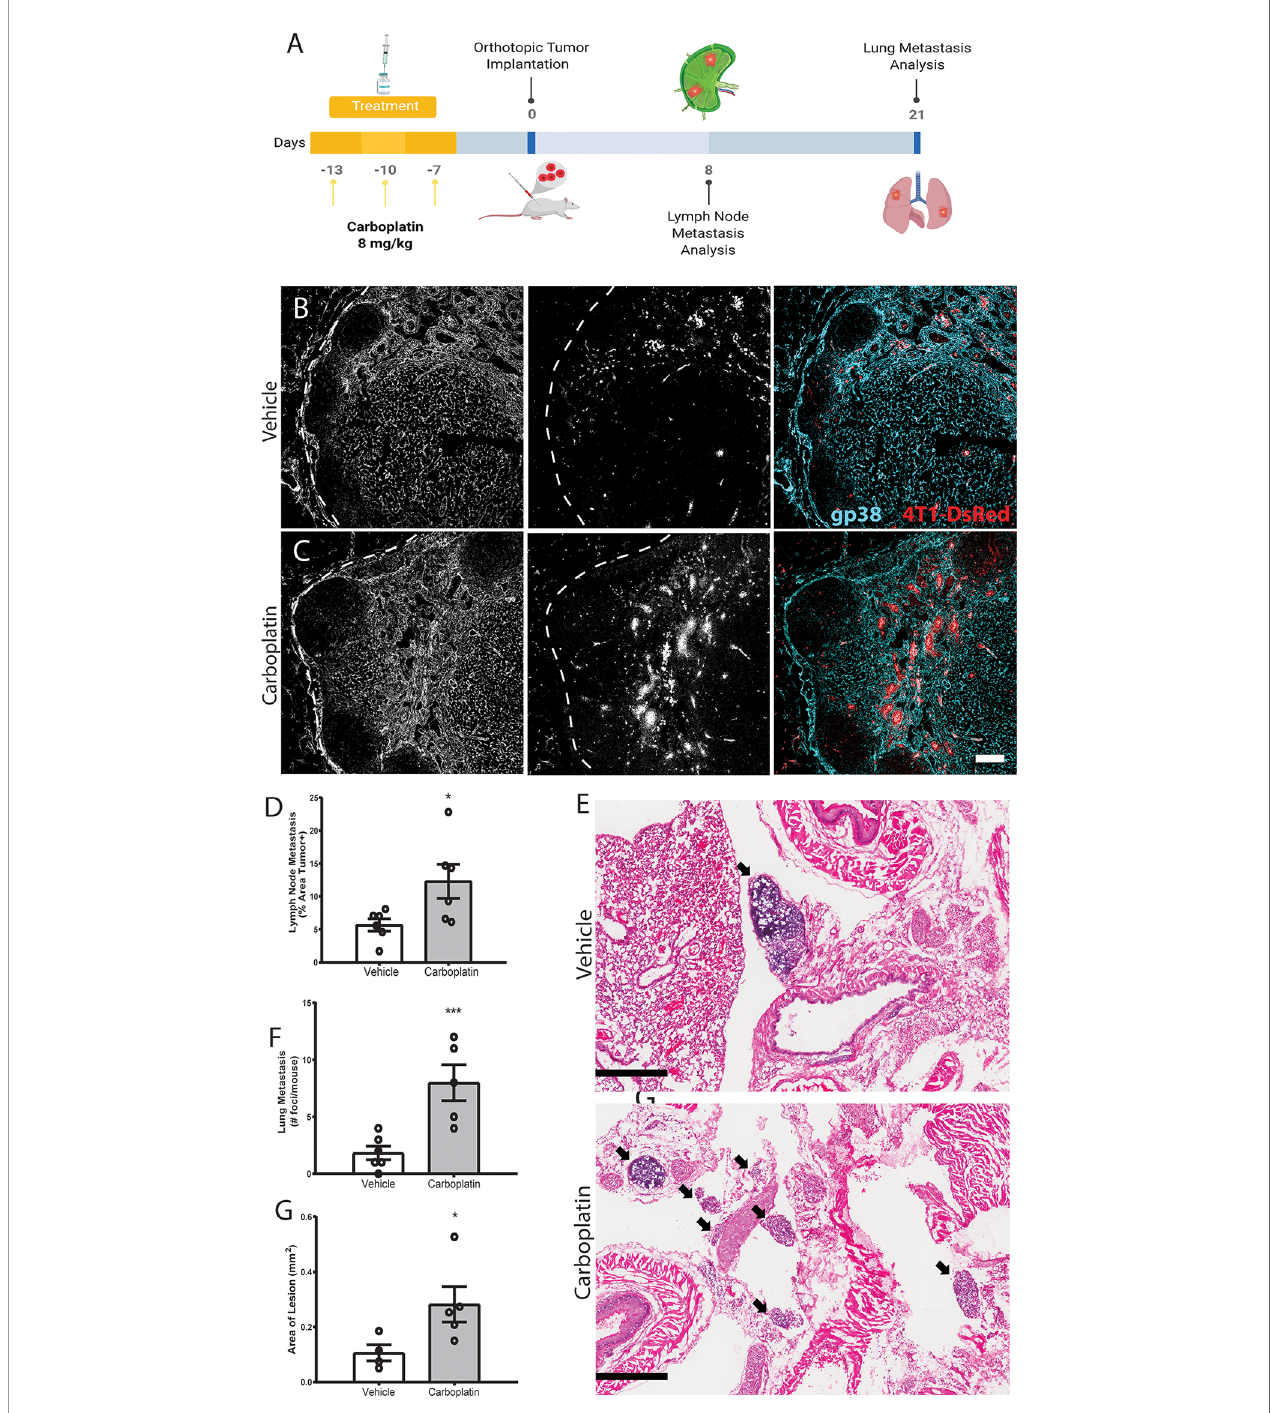
FIGURE 5 | Systemic pre-treatment with carboplatin increases metastatic spread of 4T1 breast tumors (A) Experimental timeline for carboplatin pretreatment (8 mg/kg x 3 or vehicle) followed by 4T1 tumor implant and subsequent tissue harvest. n=6/group (B) Representative images of 4T1 cells (red) in vehicle pretreated tumor-draining inguinal lymph nodes (TDLN) counterstained with podoplanin (cyan). (C) Representative images from carboplatin pretreated TDLNs. Scale bar=100µm. (D) Percentage of TDLN area covered by tumor cells as assessed by image thresholding in ImageJ. (E) Representative images of lung metastases at endpoint by H&E in vehicle (top) and carboplatin (bottom) -primed mice, denoted by arrowheads. Scale bar = 500 µm. (F) Number of metastatic foci in lung per mouse. (G) Area of macroscopic metastatic lesions in lung. *p < 0.05, ***p < 0.005 as analyzed by individual t test. Each data point represents one